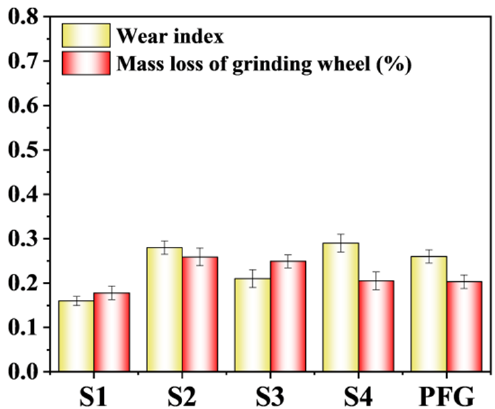
Figure 6. Abrasion resistance of the different grinding wheels.